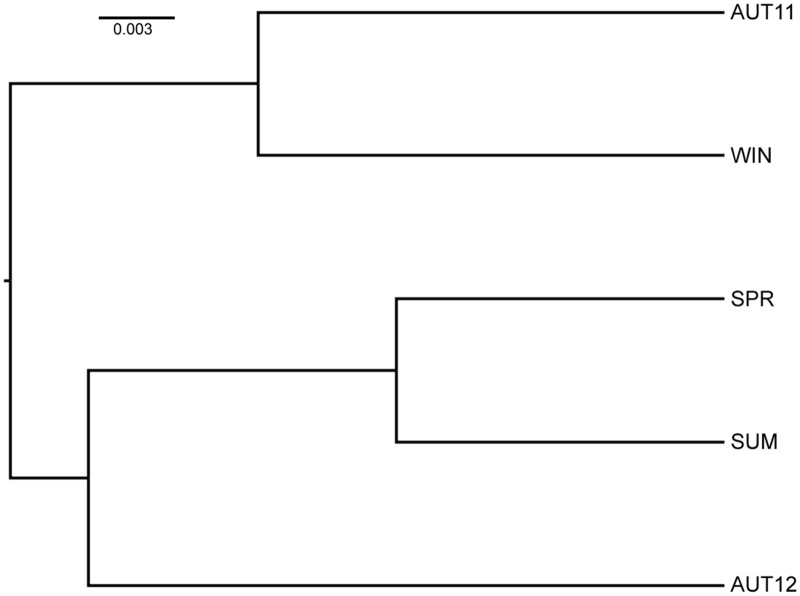
UPGMA dendrogram using Nei’s genetic distance between chronological samples.